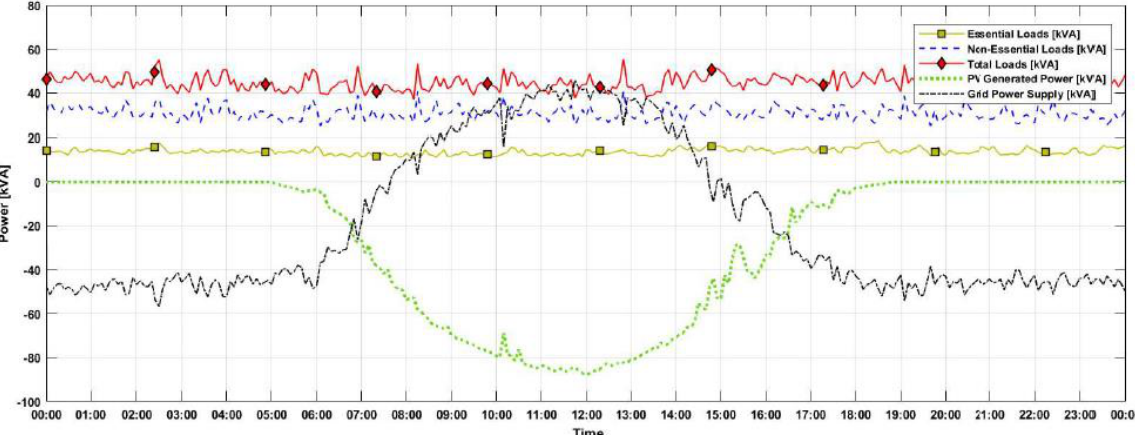
Figure 13. The behavior of MCAST micro-grid with increased PV capacity on a typical Sunday.